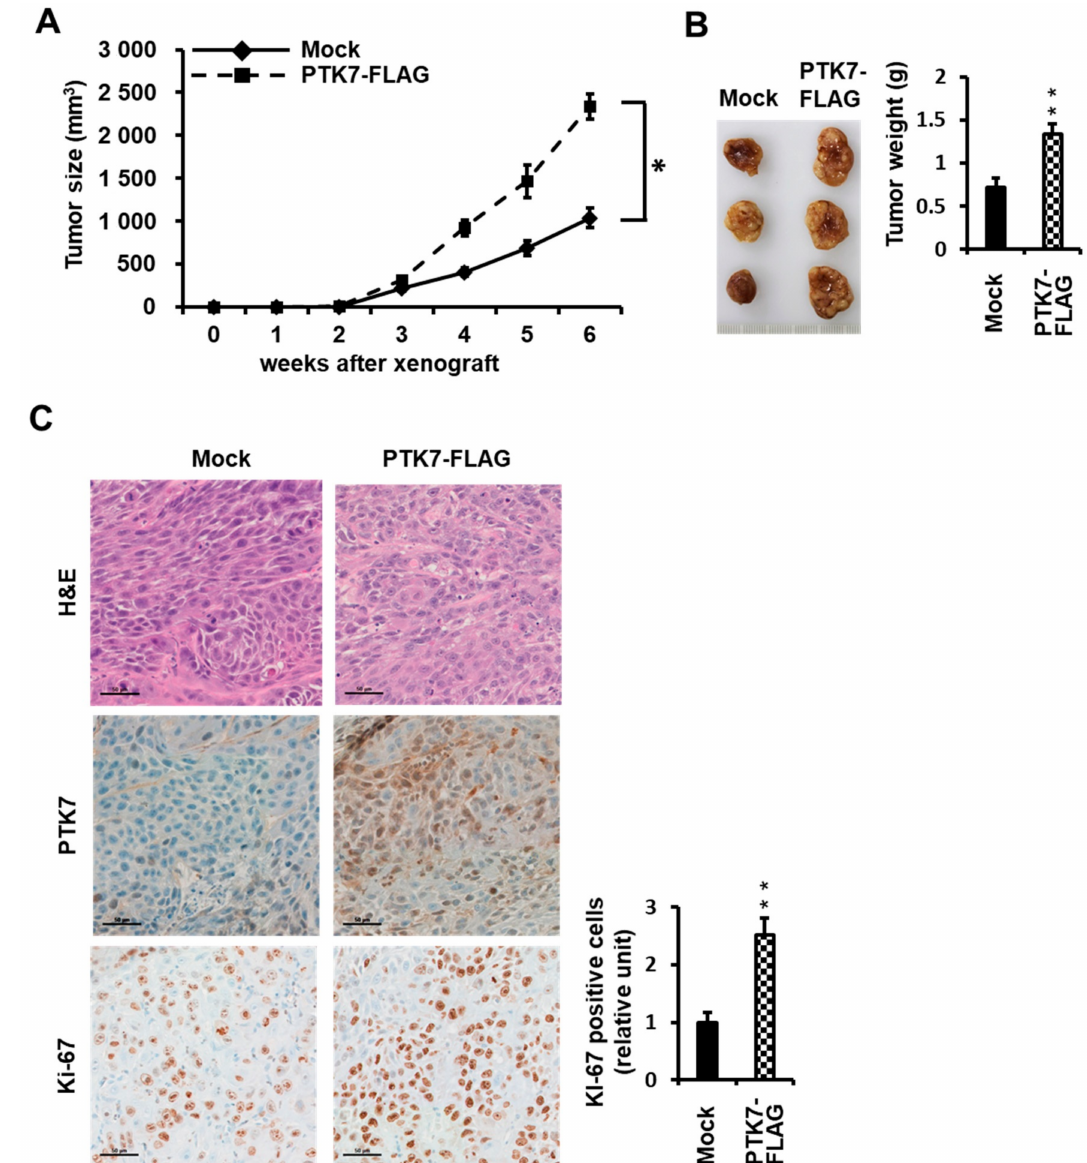
Figure 4. Effect of PTK7 overexpression on tumor growth in xenograft mice. KYSE-30 cells with mock- transfected or overexpressing PTK7-FLAG were injected subcutaneously into the dorsal regions of mice. ( A ) Tumor volumes were monitored once per week for 6 weeks. ( B ) Images of tumors from mice at 6 weeks after injection (left) and the corresponding weights (right) are shown. Each bar represents the mean ± SD of the three mice. * p < 0.05, ** p < 0.01 vs. mock-transfected cells. ( C ) Representative images of histologic and immunohistochemical (PTK7 and Ki-67) analysis of tumors are shown in the indicated groups of mice. Scale bar represents 50 µ